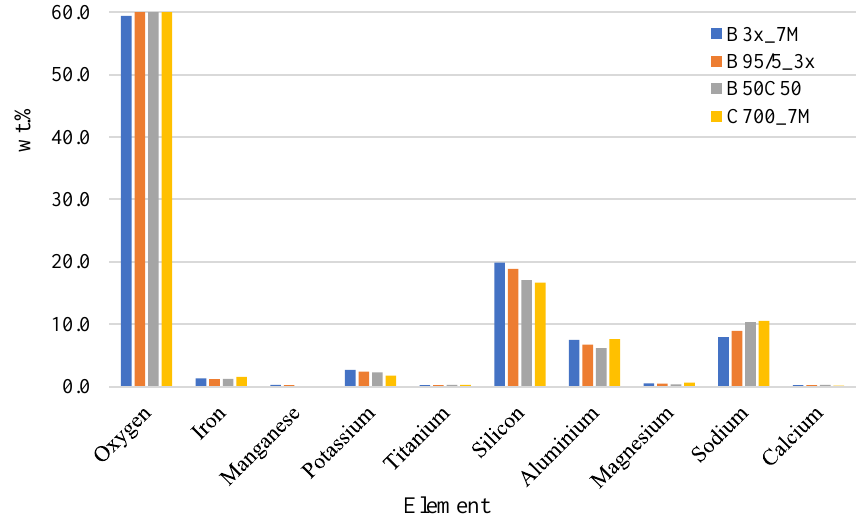
Figure 6. The EDS results of AAM with different